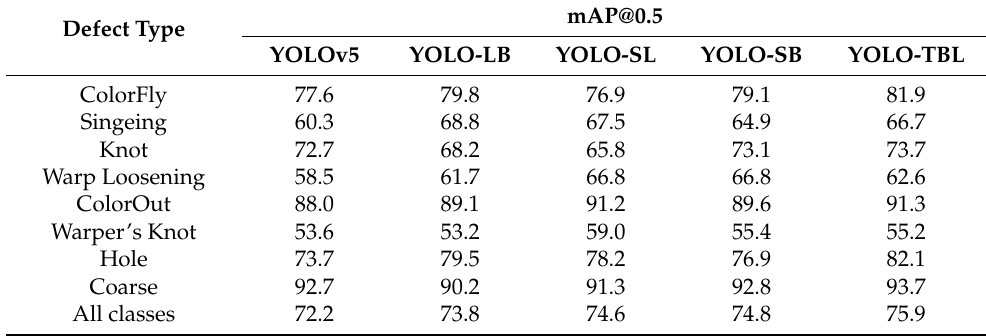
Table 4. Results for each fabric defect